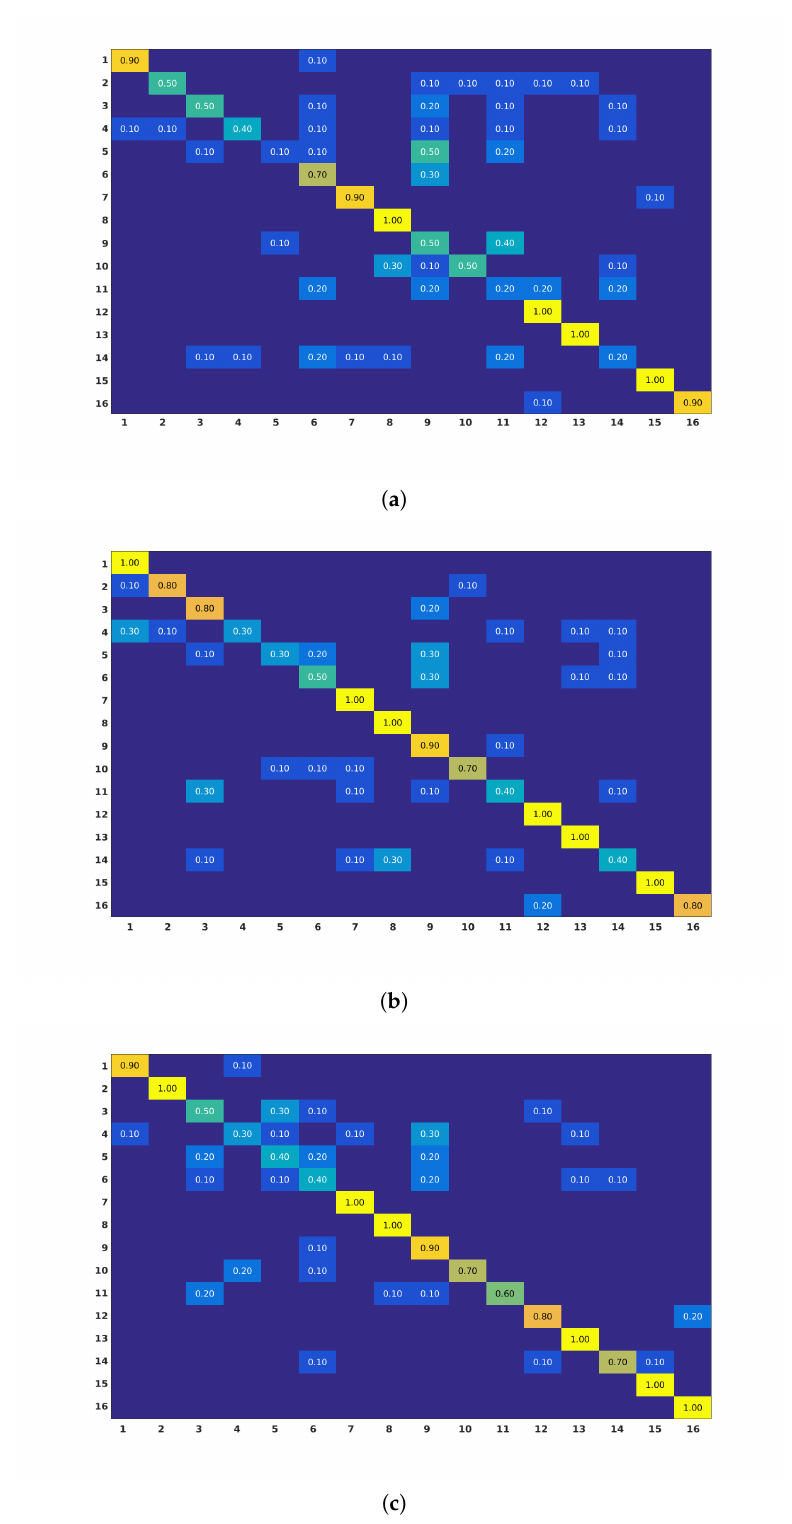
Figure 8. Confusion matrices obtained for ( a ) Dense Trajectories, ( b ) 2D Localized Trajectories and ( c ) 3D Localized Trajectories approaches on MSR DailyActivity 3D dataset. Actions list: (1)